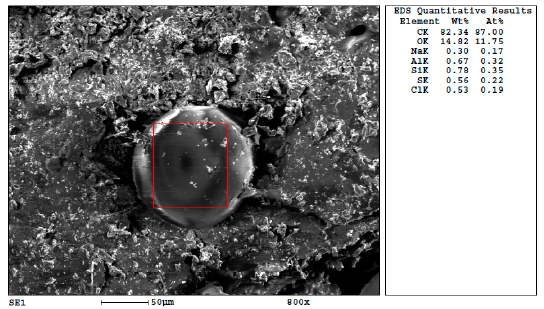
Figure 8. The energy dispersive X ‐ ray (EDX) results of composition of fluid drops.